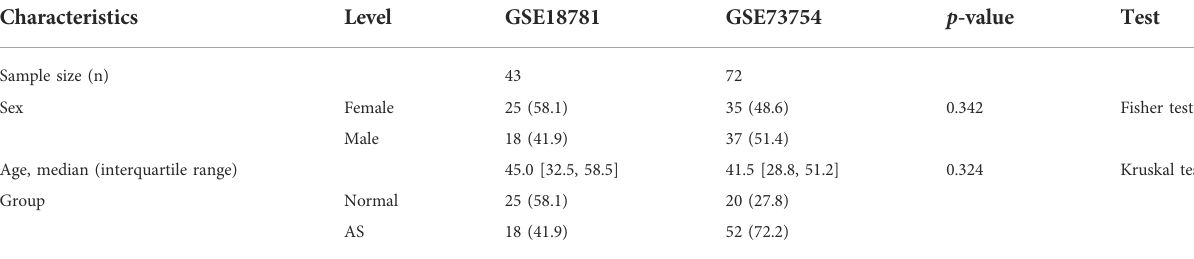
TABLE 1 Clinical characteristics in training and validation